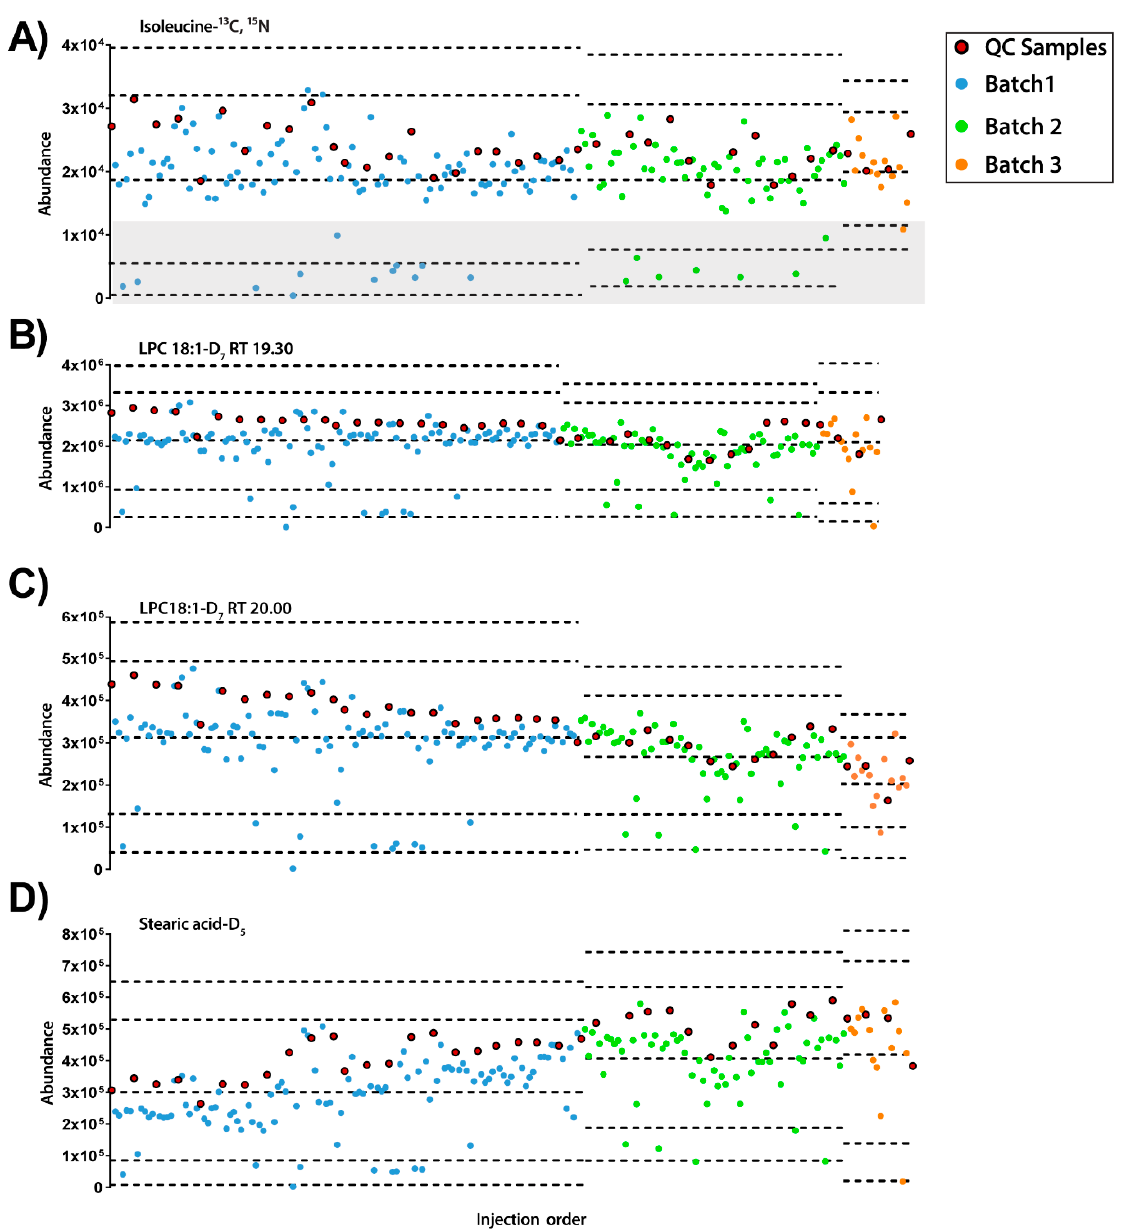
Figure 3. Quality control charts of the abundance of IS compounds in each sample according to the injection order for ESI − mode. ( A ) Isoleucine- 13 C, 15 N at RT 0.77 min, RSD = 25.01%. Grey rectangle signals samples with low levels of IS mix. ( B ) LPC18:1-D 7 RT 19.30 min, RSD = 23.93%. ( C ) LPC18:1-D 7 RT 20.00 min, RSD = 21.22%. ( D ) Stearic acid-D 5 RT 34.54 min, RSD = 30.03% Legend. Y -axis: Abundance. X -axis: Sample order. Red circles : QCs; blue and green circles : experimental samples measured in batch 1 and batch 2, respectively. Dotted lines represent the mean +/ − 2 and 3 SD for each batch independently.